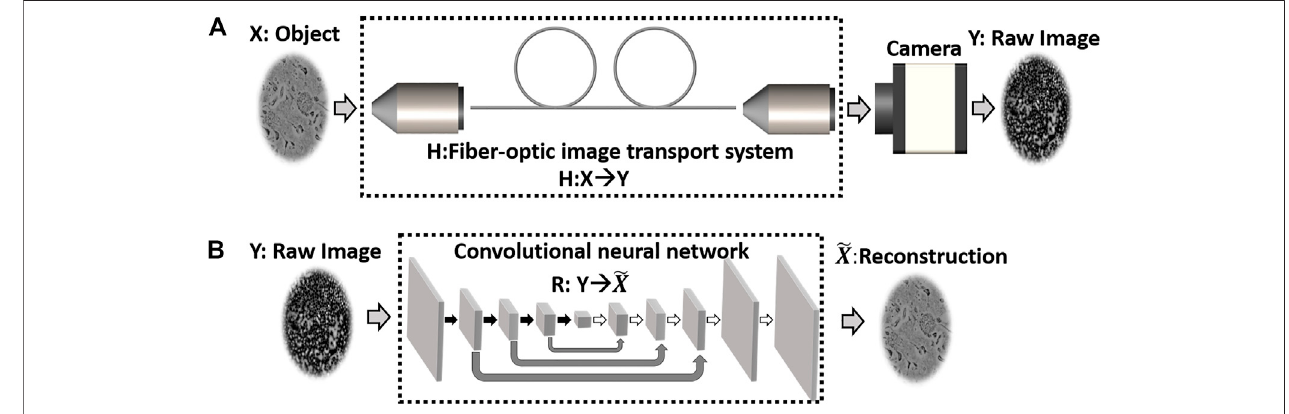
FIGURE 6 | (A) A general fi ber-optic imaging system. The physics model of the fi ber-optic imaging system can be treated as a forward operator H . H acts on the object X to generate the raw image. A digital camera collects the raw image Y , (B) Learning-based approach (convolutional encoder-decoder architecture) to solve the inverse problem of reconstructing X from the raw image. R stands the inverse operator that maps the raw image into (cid:1) X , the estimation of the object.